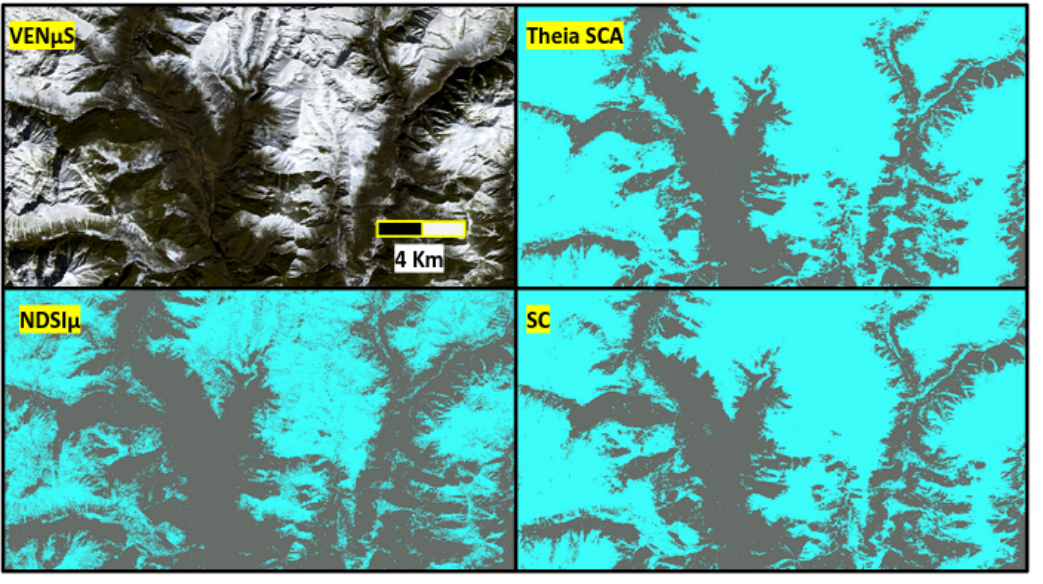
Figure 6. Visual comparison of VEN µ S true color image, and the snow mask of the different products: derived from Theia (Theia SCA), by using NDSI µ and the supervised classification (SC). The comparison was performed in a sub-region located in both VEN µ S and T31TCH